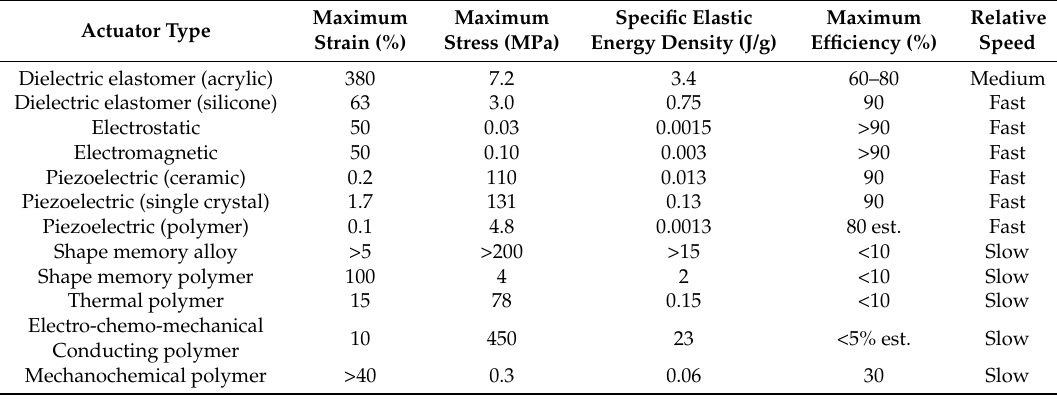
Table 2. Overview characteristics of smart actuators [43].